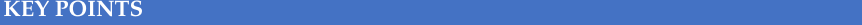
Table 1. Sperm DNA fragmentation has emerged as one of the most controversial topics in male reproductive medicine. Included here are several key points that are discussed in greater depth throughout the article. TABLE 1: KEY